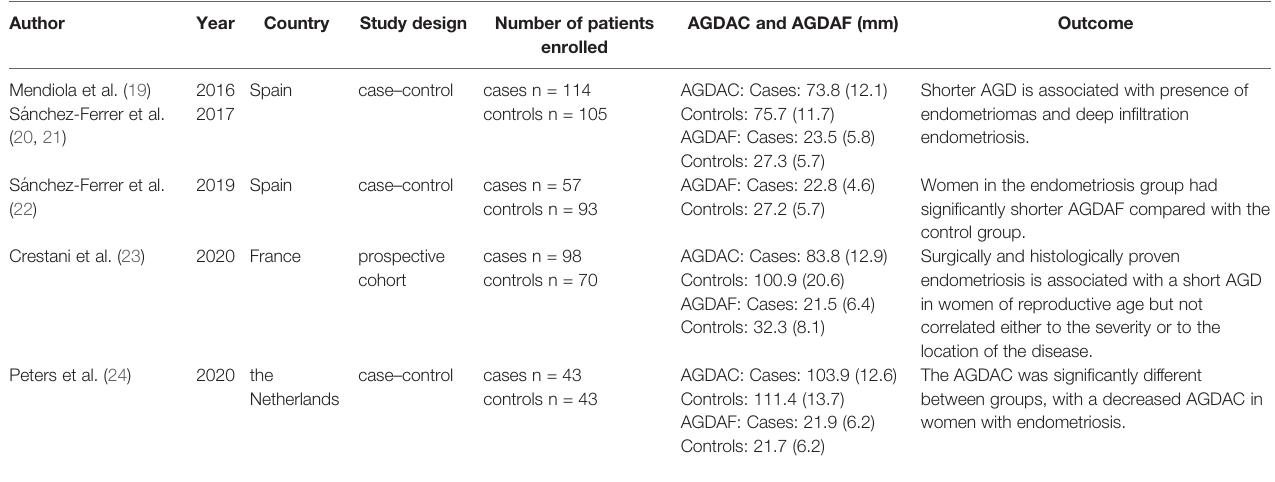
TABLE 1 | Studies evaluating anogenital distance in women with